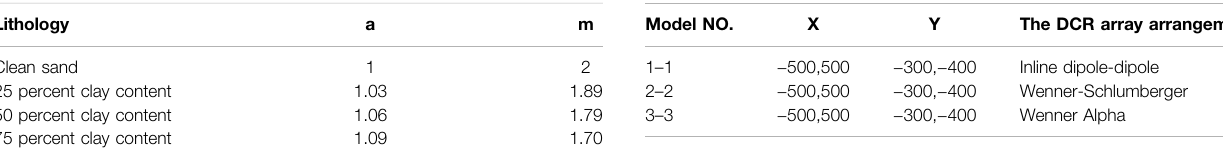
TABLE 1| Comparison betweenargillaceous claycontent and aand m value (Lee and Collett, 2006).